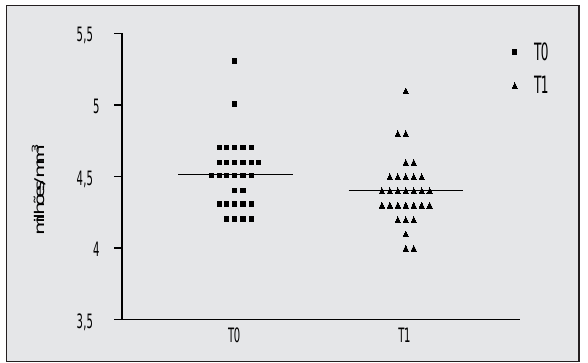
Figura 2 – Distribuição dos valores de hemoglobina das pacientes antes (T0) e após (T1) a reposição hormonal. Não houve diferença estatisticamente significativa